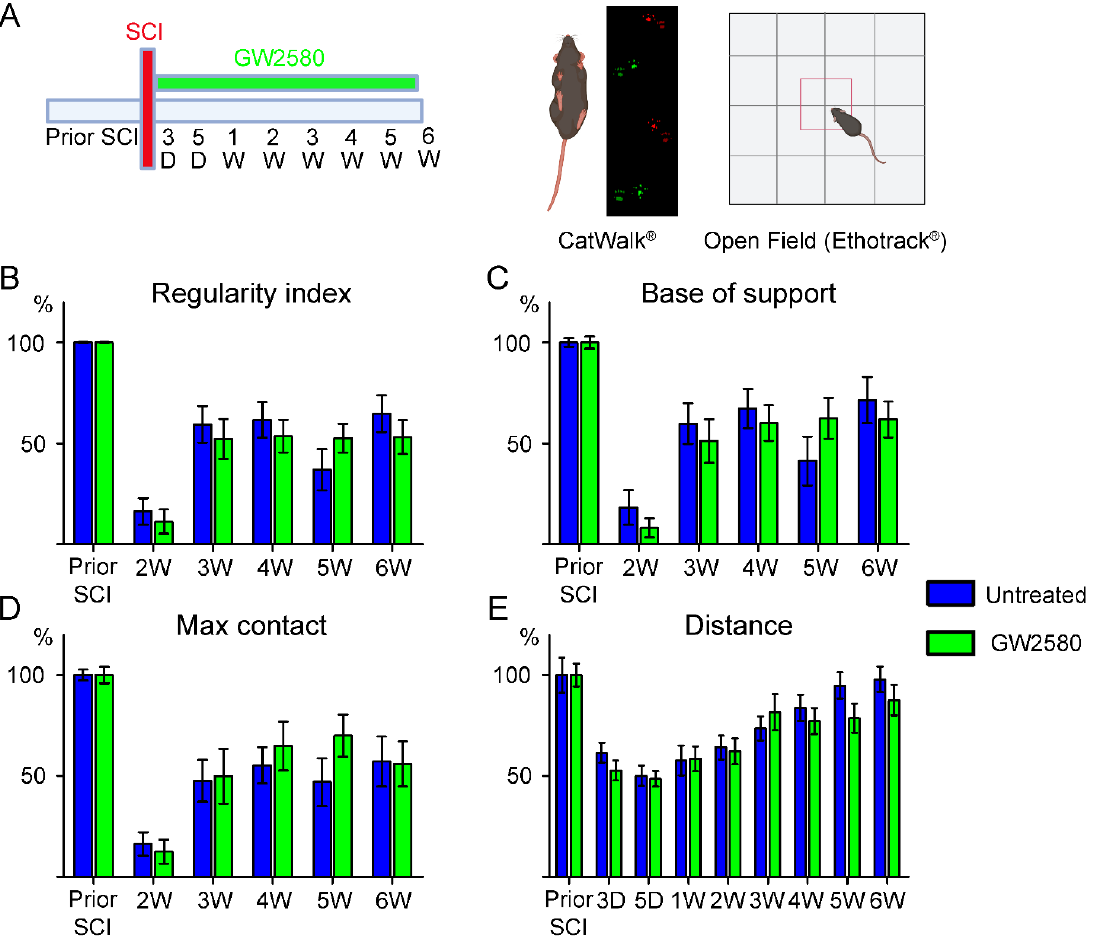
Figure 1. Effects of a long-term GW2580 treatment post-injury on motor activity. Timeline of the experimental procedure corresponding to 6 weeks of oral GW2580 treatment (or control food) after injury and longitudinal behavioral follow-up using a combination of gait and open field analyses ( A ). Parameters used to analyze fine motor activity using Catwalk ® include: regularity index ( B ), hindlimbs base of support ( C ), and max contact (%) of the ipsilateral hind paw ( D ). Analysis of the distance covered per mice in an open field ( E ). Results are expressed as mean ± SEM per time-point in untreated (blue) and GW2580-treated groups (green). Statistics: two-way repeated-measure analysis of variance, followed by Bonferroni post-hoc test. Number of mice: 14 mice were used per experiment, per condition, and per time-point.